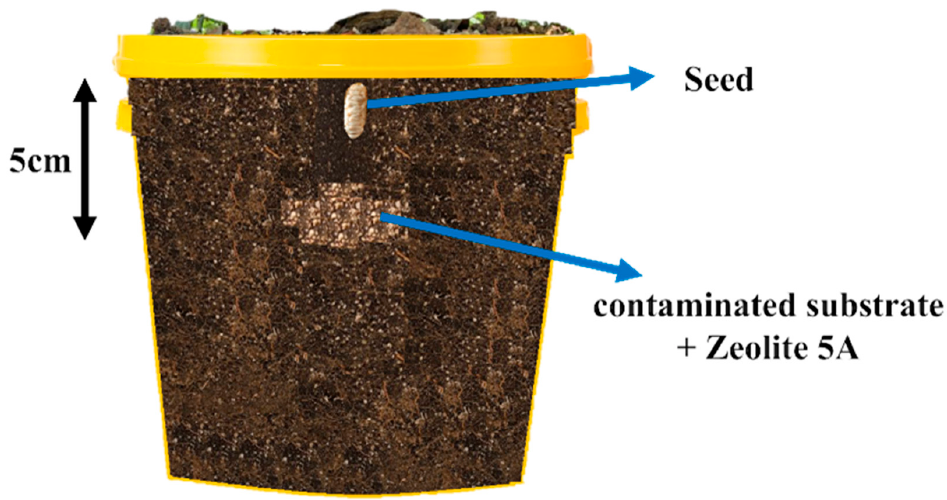
Figure 2. Graphic scheme used for the implementation of zeolite 5A in a pot for the cultivation of cacao seedlings.